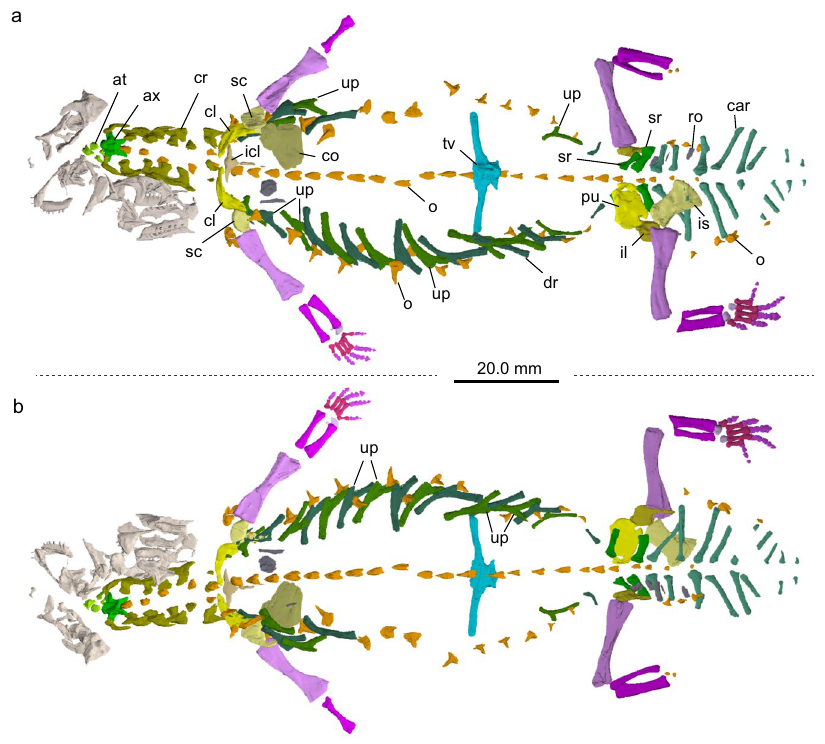
Figure 3. Virtual reconstruction of Eusaurosphargis dalsassoi (PIMUZ A/III 4380) with focus on postcranial elements. ( a ) Ventral and ( b ) dorsal view. Note that due to preservational aspects, not all bones of the skeleton were reconstructed. Unidentified bones are shown in dark grey and skull bones in light grey. Abbreviations used in the figure are atlas complex (at), axis (ax), caudal rib (car), clavicle (cl), coracoid (co), cervical rib (cr), dorsal (thoracic) rib (dr), interclavicle (icl), ilium (il), ischium (is), osteoderm (o), pubis (pu), rectangular osteoderm (ro), scapula (sc), sacral rib (sr), thoracic vertebra (tv), and uncinate process